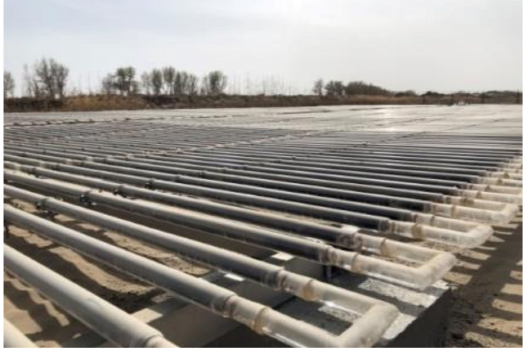
Figure 7. Arrangement of the